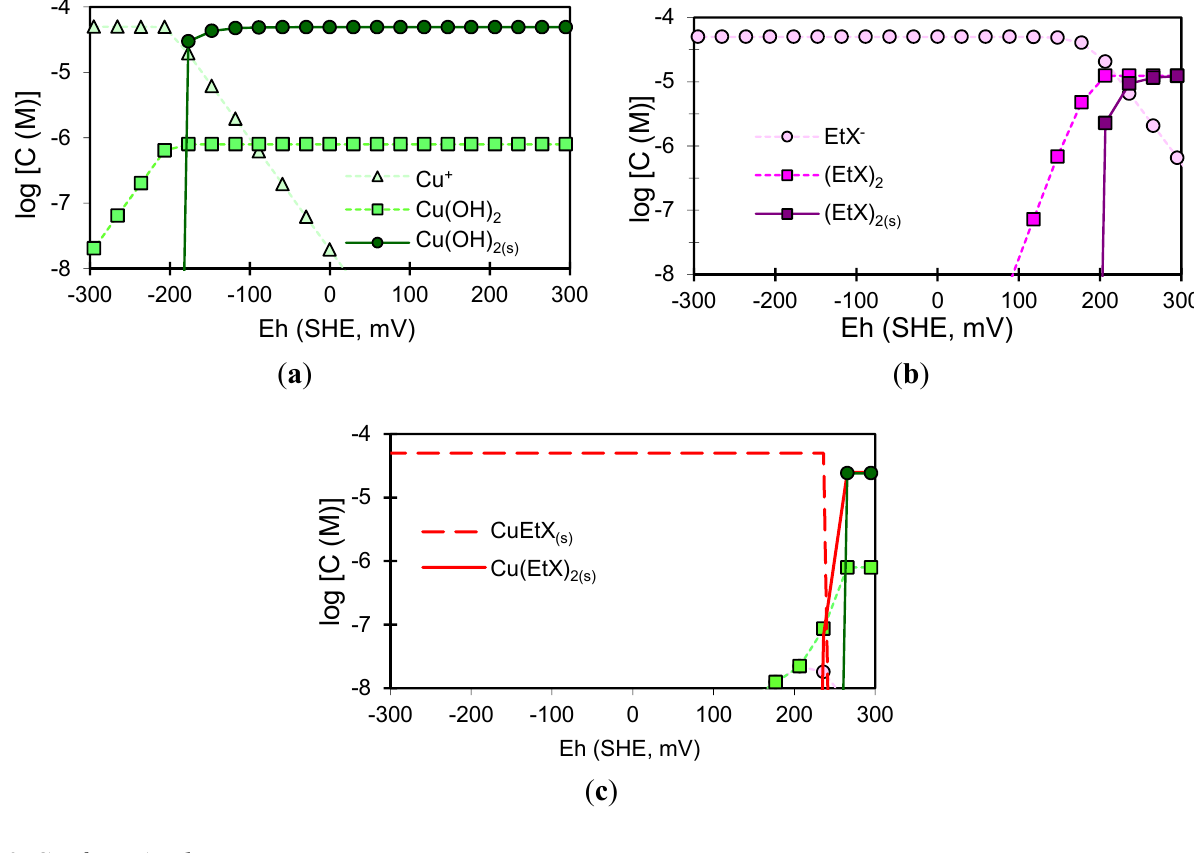
at pH 9. The legend in ( c ) h